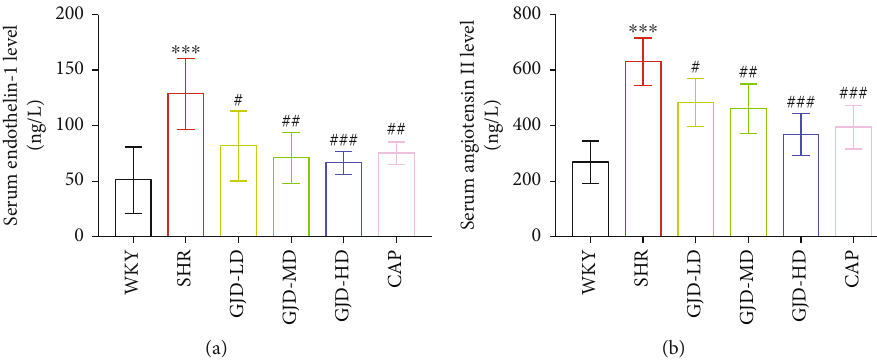
Figure 2: Serum level of endothelin-1 and angiotensin II. WKY indicates the WKY control group, SHR indicates the SHR model group, GJD-LD indicates the SHR treated with GJD at a low dose, GJD-MD indicates the SHR treated with GJD at a medium dose, GJD-HD indicates the SHR treated with GJD at a high dose, and CAP indicates SHR treated with captopril. Data are means ± SD , n = 7 . ∗ P < 0 : 05 , ∗∗ P < 0 : 01 , ∗∗∗ P < 0 : 001 vs. WKY group, # P < 0 : 05 , ## P < 0 : 01 , ### P < 0 : 001 vs. SHR